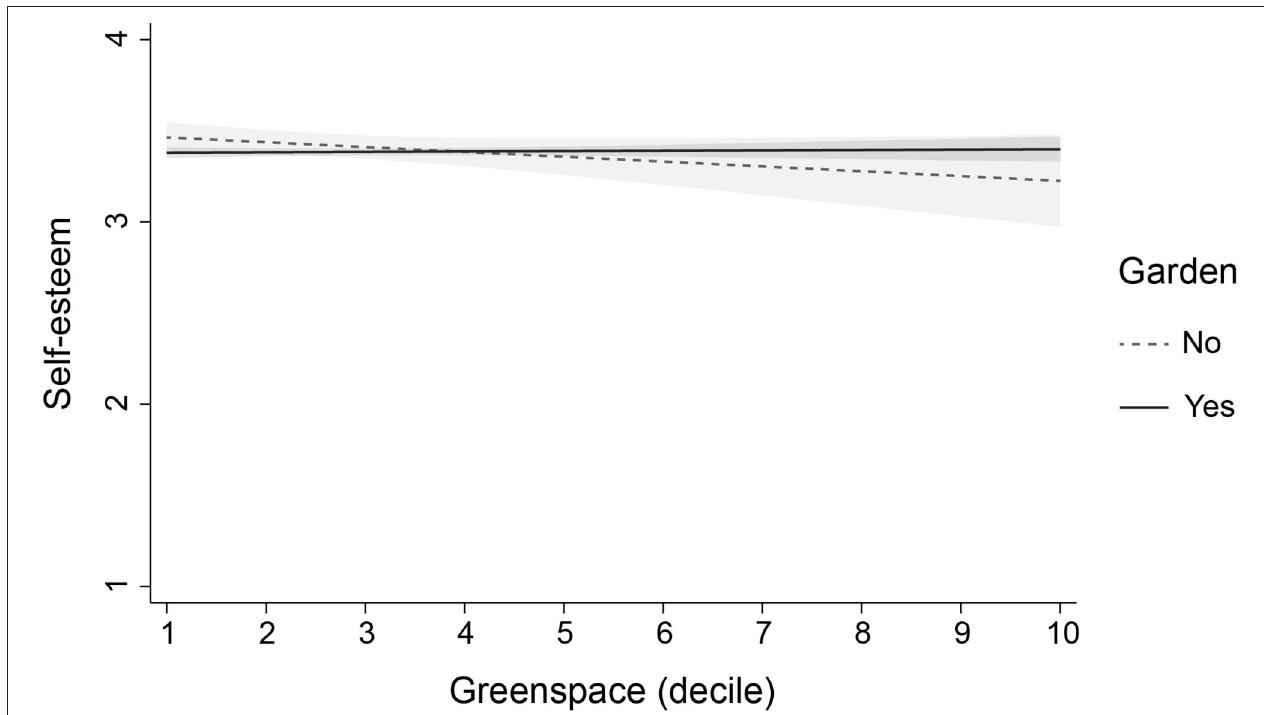
FIGURE 1 | Modification of the effect of greenspace on self-esteem by garden access. This plot illustrates the modifying role of garden access in the association of greenspace with self-esteem (linear predictions). Plots are based on non-imputed data. Shaded areas are 95% confidence